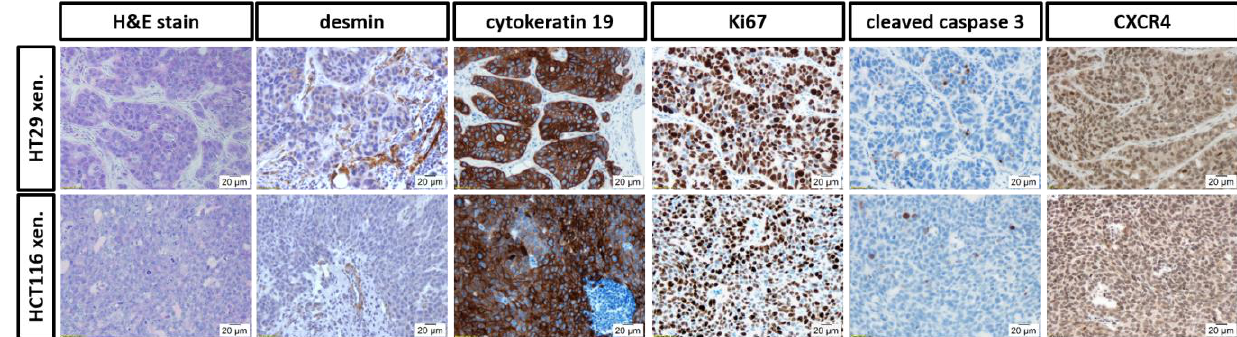
Figure 8. Characterisation of HT29 (upper row) and HCT116 (lower row) CAM-xenografts. Representative pictures of different stainings performed on CAM-xenografts. From left to right: H&E stain; anti-desmin staining (pericytes in the vascular network); anti-cytokeratin 19 staining (epithelial cells); anti-Ki67 staining (proliferating cells); anti-cleaved caspase 3 staining (apoptotic cells) and anti-CXCR4 staining (target of interest). Magnification: 200-fold. At least three sections from different specimens were stained per cancer cell line and tumour marker.